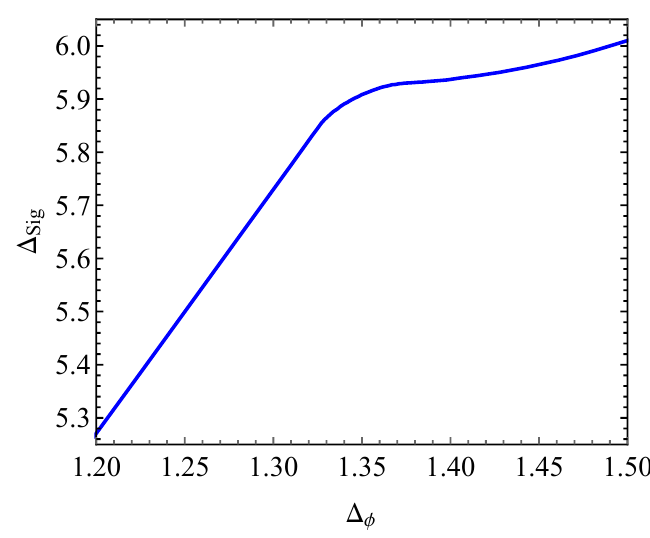
Figure 6 . Bound ( Λ = 31 ) on the scaling dimension of the lowest SO(4 2 − 1) singlet